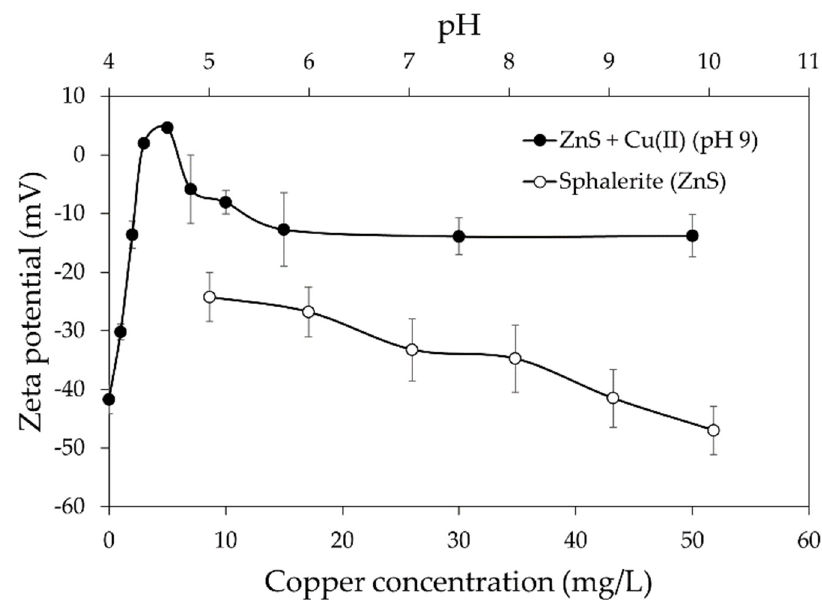
Figure 1. Zeta potential of sphalerite as a function of conditioning pH and Cu-activated sphalerite at pH 9 as a function of Cu(II) concentration (constant ionic strength of 10 − 3 mol/L NaNO 3 ). It can also be observed in Figure 1 the effect of Cu(II) concentration on the zeta potential of sphalerite at pH 9. Zeta potential increases as the Cu(II) concentration is varied from 0 to 5 mg/L. This behavior is due to the adsorption of copper hydroxide species onto the sphalerite surface and the exchange of Zn 2+ of the crystal lattice by Cu 2+ . Then, cupric ions react with the nearby sulfides oxidizing them, leading to the formation of a new surface consisting of cuprous sulfide (Cu 2 S) and polysulfides (e.g., Sn 2 − , or cuprous disulfide